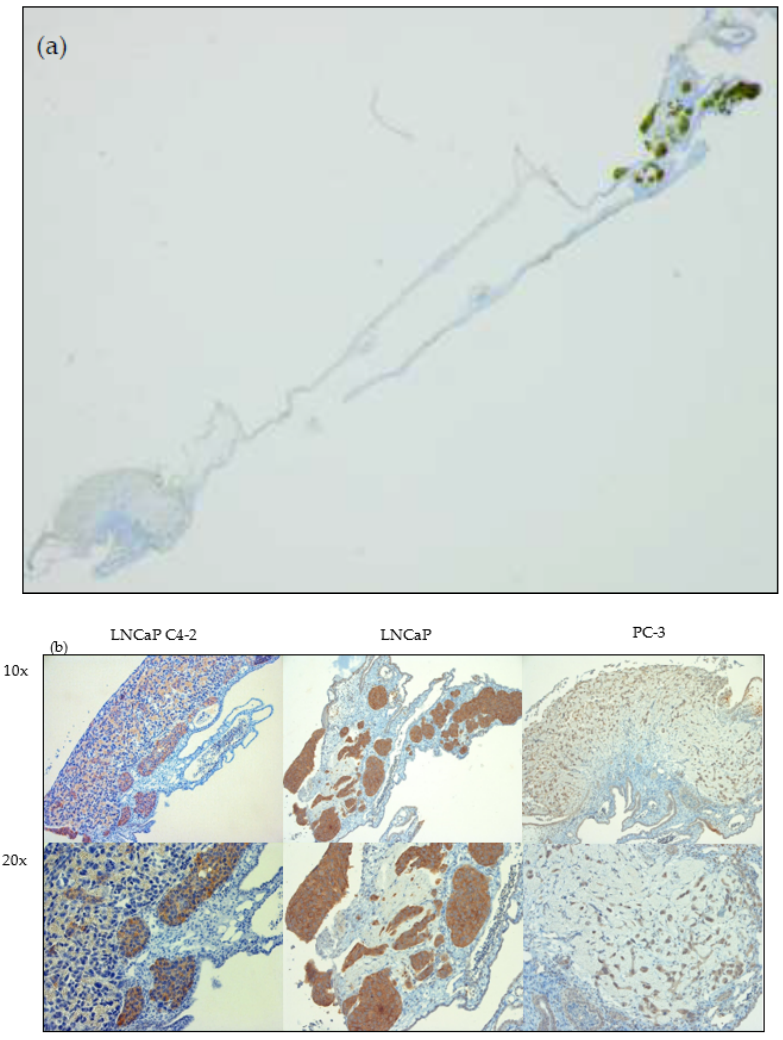
Figure 5. Immunohistochemical staining of HET-CAM tumor xenograft sections using an anti-PSMA antibody. Sections of each cell line specific tumor xenograft were used as an example. In image ( a ) an overview section is depicted. PC-3 and LNCaP tumor xenografts were stained simultaneously. In part ( b ) two magnifications (10 × ; 20 × ) of the tumor entities are depicted and an intense staining of the PSMA protein is clearly visible in the sections of LNCaP C4-2 and LNCaP (brown color), while a weak staining is visible for PC-3.